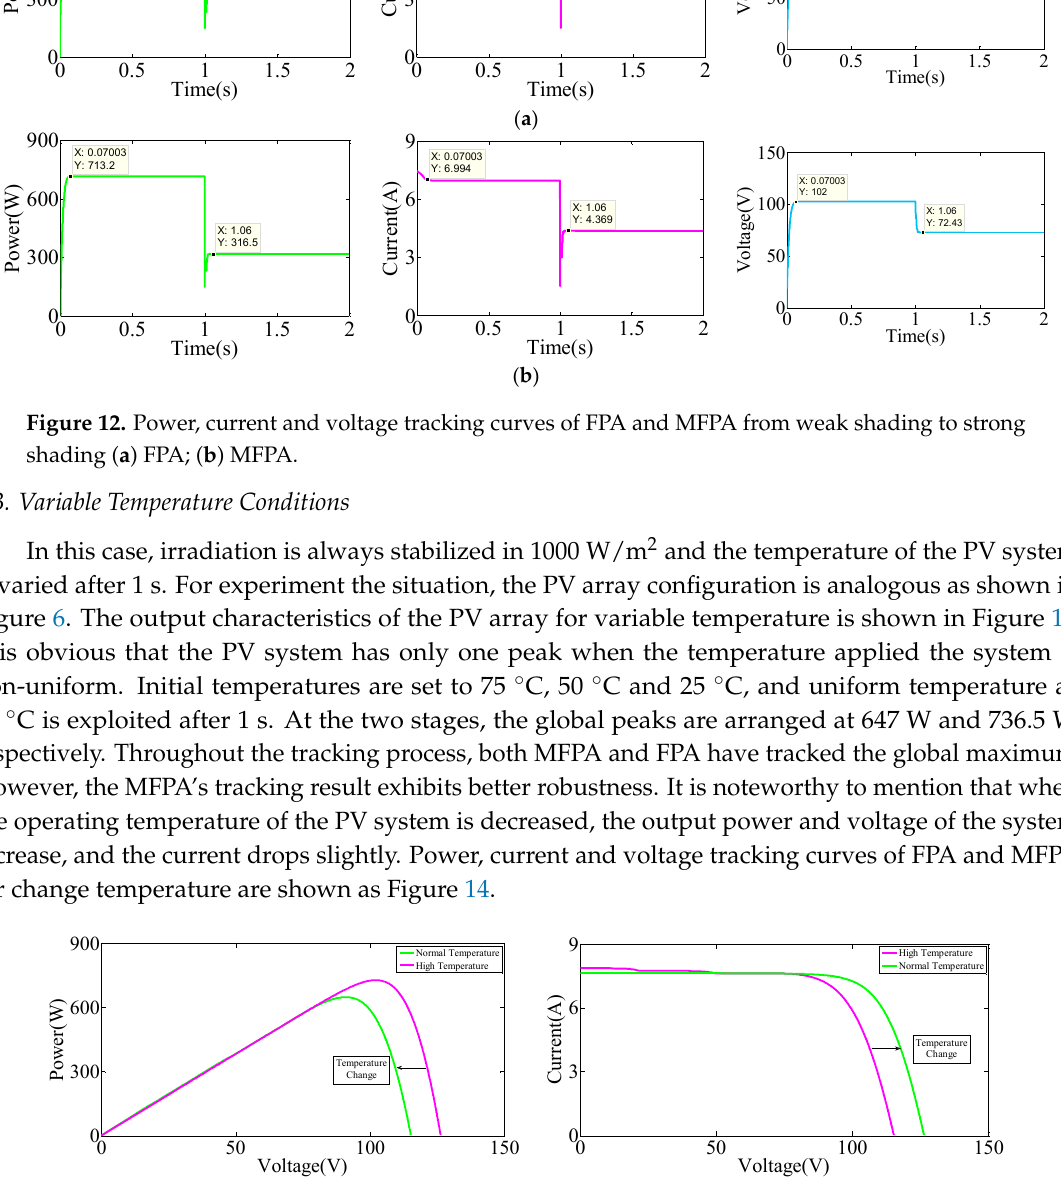
Figure11. Power, current and voltage tracking curves of FPA and MFPA from strong shading to weak shading ( a ) FPA; ( b ) MFPA.